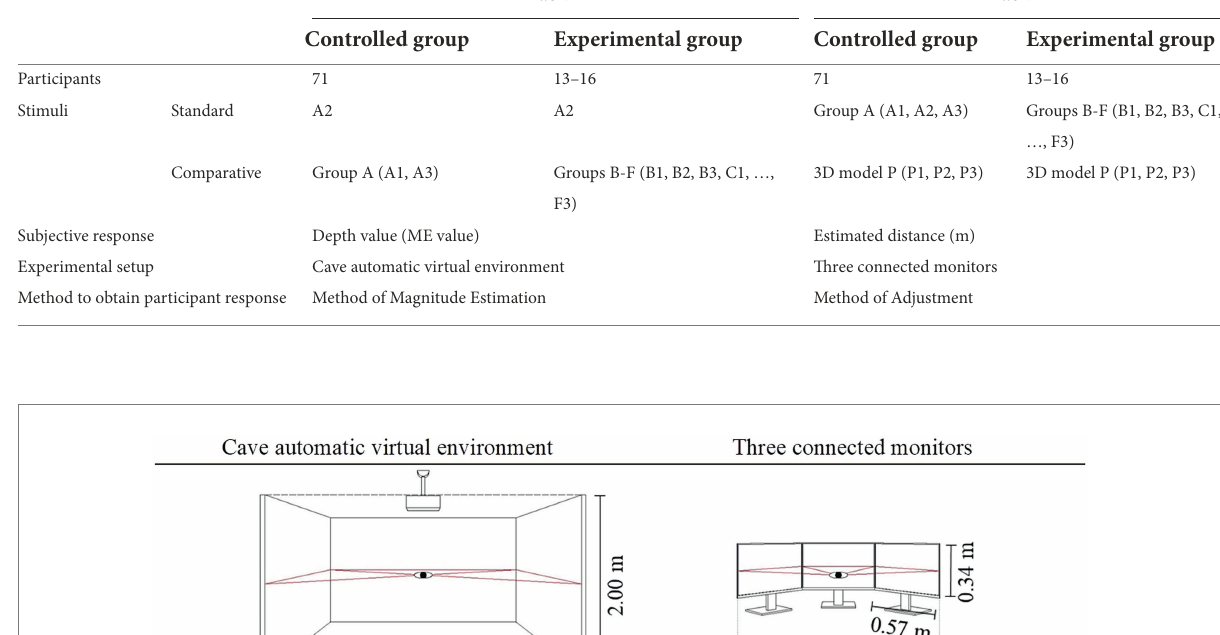
TABLE 3 General overview of the two tasks.